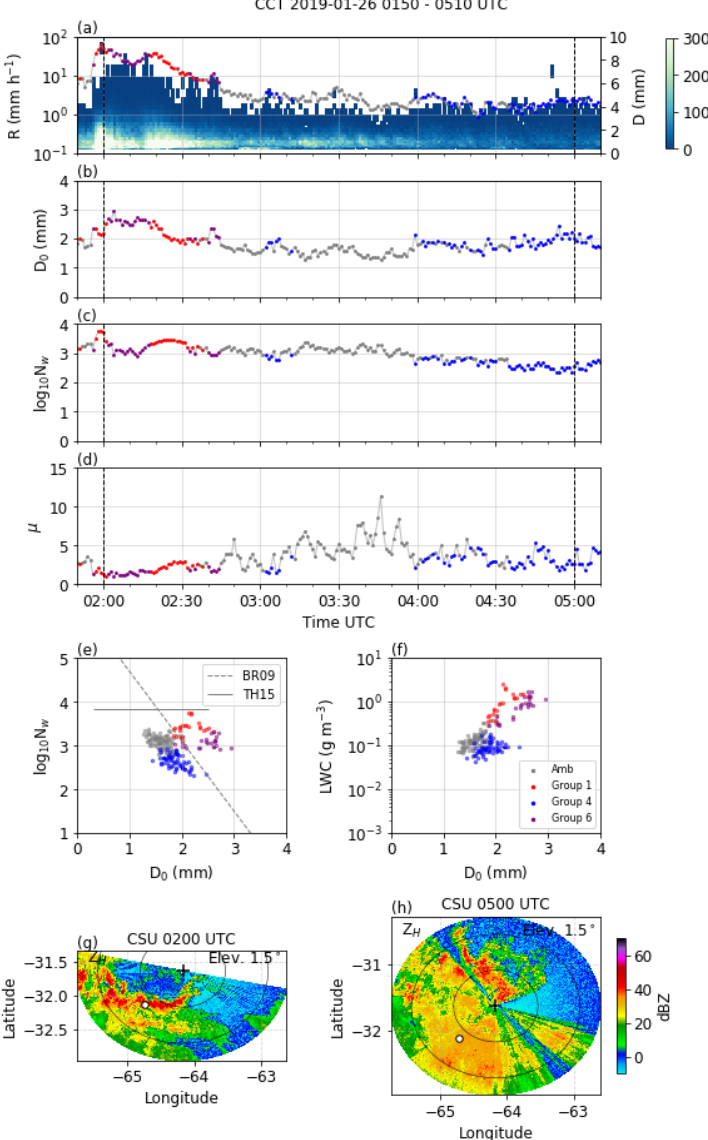
Figure 8. Temporal evolution of ( a ) R (dots) and N(D) (color shading), ( b ) D 0 , ( c ) log N w , and ( d ) µ as measured by disdrometer CCT on January 26, 2019 from 0150 to 0510 UTC. Projection of each 1 min DSD in the ( e ) log N w - D 0 and ( f ) LWC- D 0 parameter spaces. PPI of Z H measured by the CSU radar at ( g ) 0200 UTC and ( h ) 0500 UTC. The marker color in ( a – f ) indicates the group according to the D18 classification. Dashed lines in ( a – d ) mark the times of the radar images. The rings in ( g , h ) indicate the 60 and 120 km ranges. The white marker shows the position of the